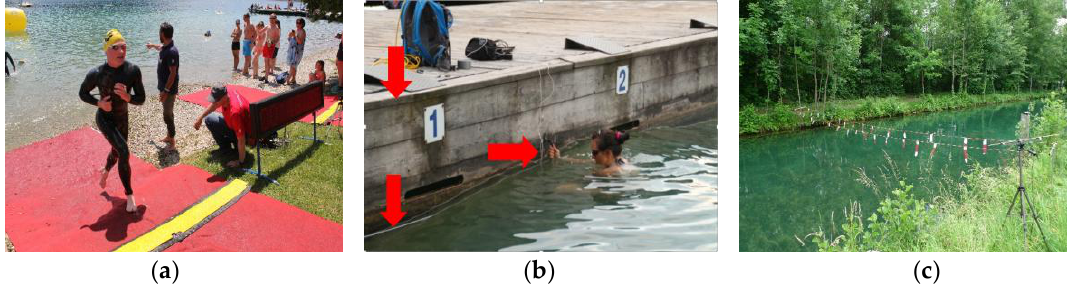
Figure 2. Four different methods to use RFID-timing in open water sports. ( a ) Onshore running section between several laps of the swimming course; ( b ) Fixing the coil at an outdoor pool edge; ( c ) Overhead antenna loop over a narrow swimming channel Table 1. An overview of the different possibilities of RFID antenna placements for open